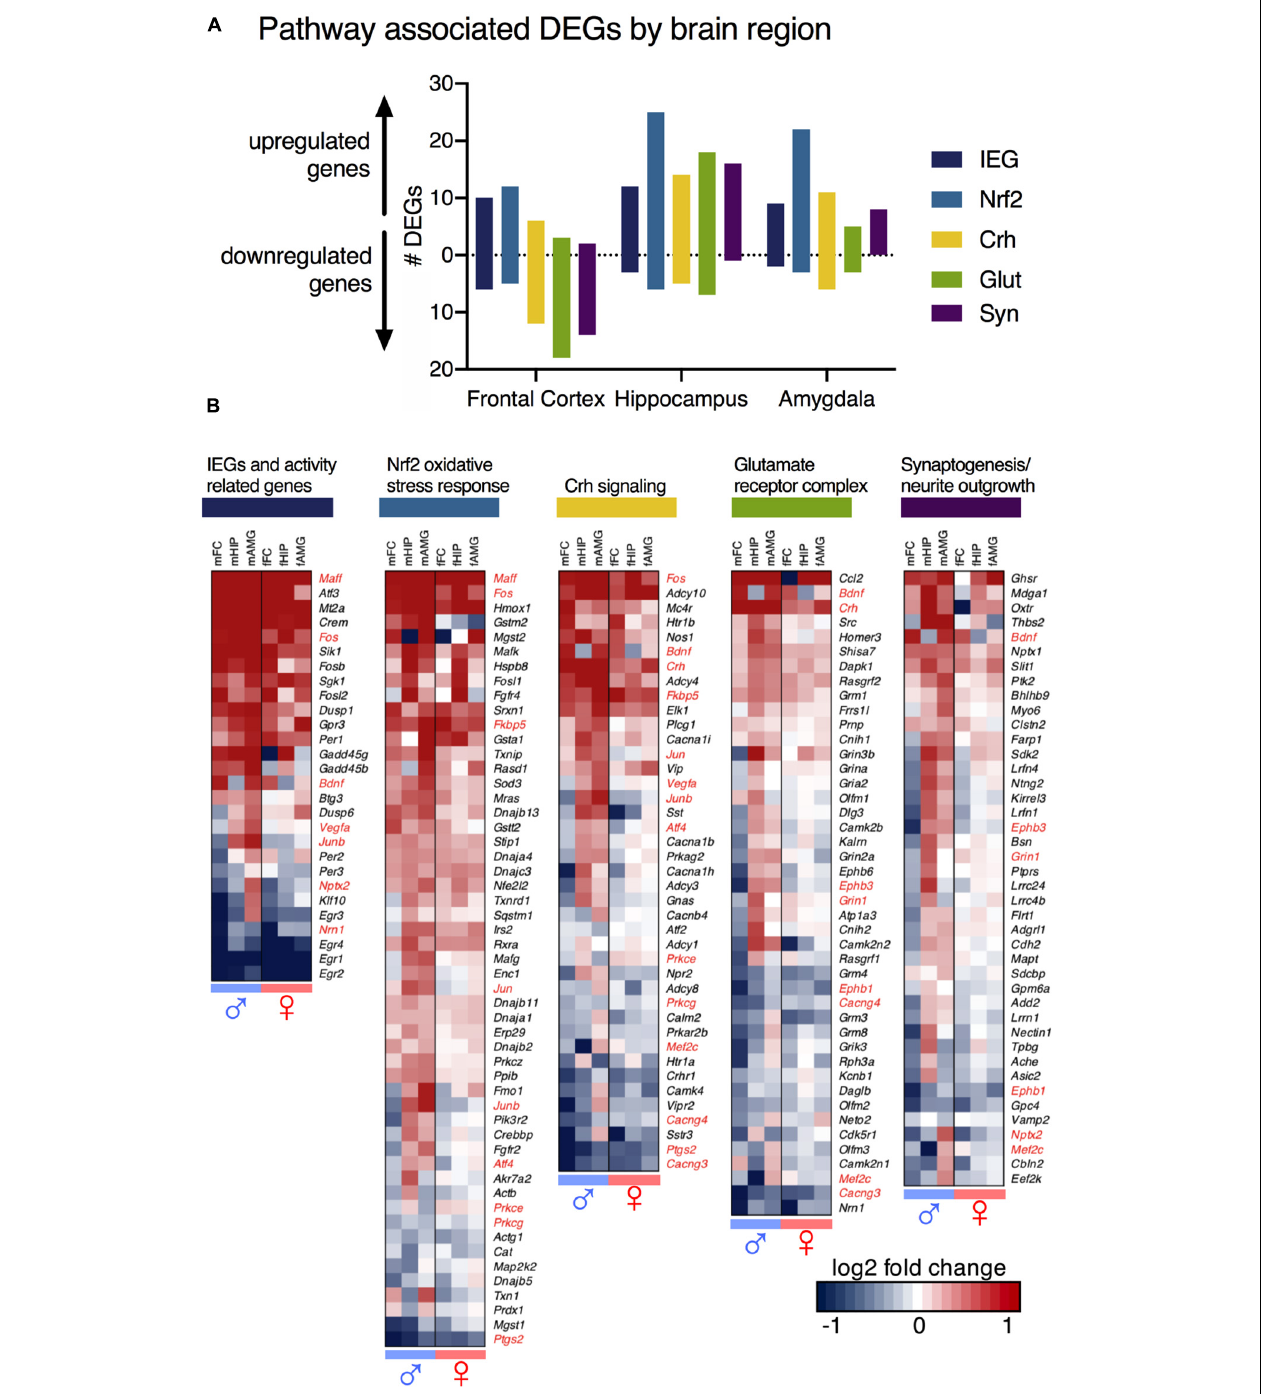
FIGURE 5 | Pathway analysis of differentially expressed genes (DEGs). DEGs that met threshold from male and female animals were analyzed for canonical pathway enrichment with Ingenuity Pathway Analysis, and Gene Ontology (GO) term enrichment DAVID Bioinformatics Resources. Four key molecular pathways are highlighted – Corticotropin releasing hormone (Crh) signaling, Nrf2 (Nuclear factor-like 2) - mediated oxidative stress response (Nrf2), Glutamate receptor complex regulation (Glut), and Synaptogenesis (Syn). (A) Total number of genes in identified pathways, by brain region. All but one molecular pathway (Nrf2) show patterns of predominant upregulation in the hippocampus and amygdala, and downregulation in the frontal cortex. The hippocampus shows the most robust change in the Nrf2 pathway. (B) Changes in each pathway, across sexes and brain regions. Genes significant and meeting threshold in at least one brain region in at least one sex for each pathway are shown. Subclasses of upregulated and downregulated genes are seen. Regional differences from male animals are mirrored as non-significant trends in female animals. Genes mapped to multiple pathways are highlighted in red.